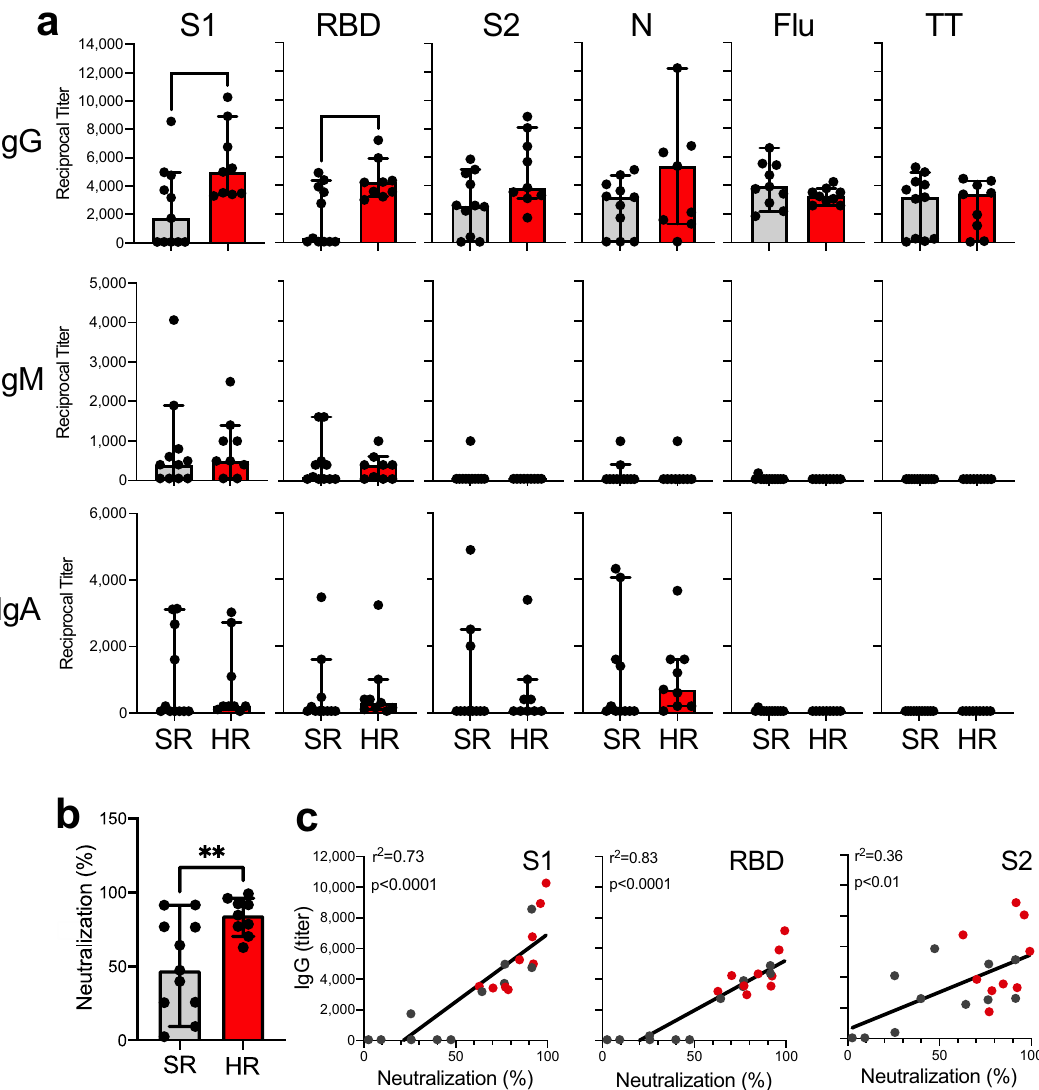
Fig. 5 Quanti fi cation of antibody titers against SARS-CoV proteins. a We performed a comparative analysis IgG, IgM, and IgA antibody titers against the SARS-CoV virus proteins S1, RBD, S2, and N in nine high-risk (HR, red bars) vs. 11 standard-risk (SR, gray bars) patients. Recombinant Flu and TT proteins served as controls. Bar graphs indicate medians and whiskers indicate ranges. Asterisks indicate signi fi cance differences between groups (* p < 0.05, ** p < 0.01). b Comparative analysis of viral neutralization in patients with high-risk vs. standard-risk COVID-19. c Correlation of viral neutralization with IgG antibody titers against S1, RBD, and S2 performing linear